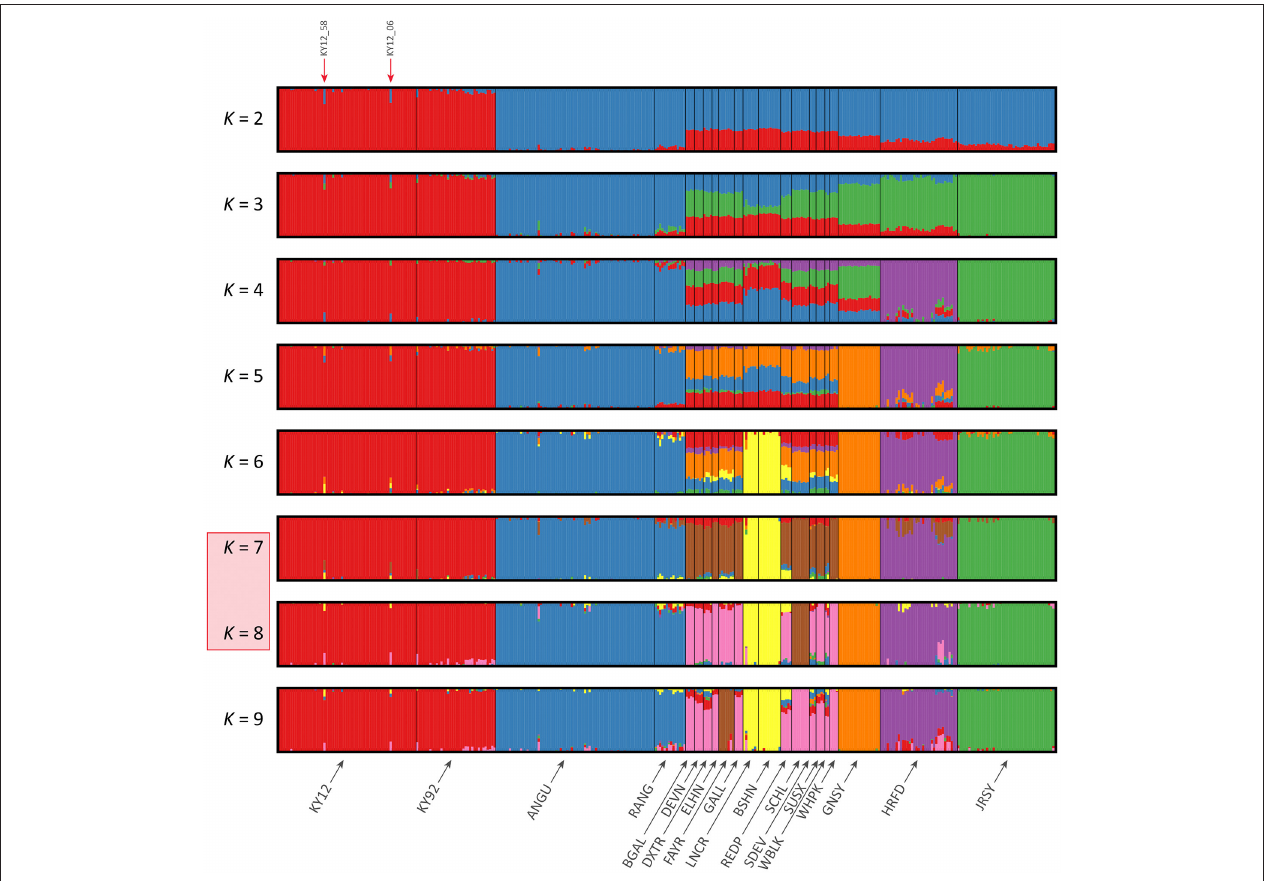
FIGURE 7 | Hierarchical clustering of individual animals using genome-wide SNP data (37,395 autosomal SNPs) for the BI data set of 351 individual animals. Results are shown for modelled ancestral populations K = 2–9. The cluster numbers corresponding to the likely number of ancestral populations are highlighted with a light red overlay and the two outlier Kerry samples (KY12_06 and KY12_58) are indicated with red